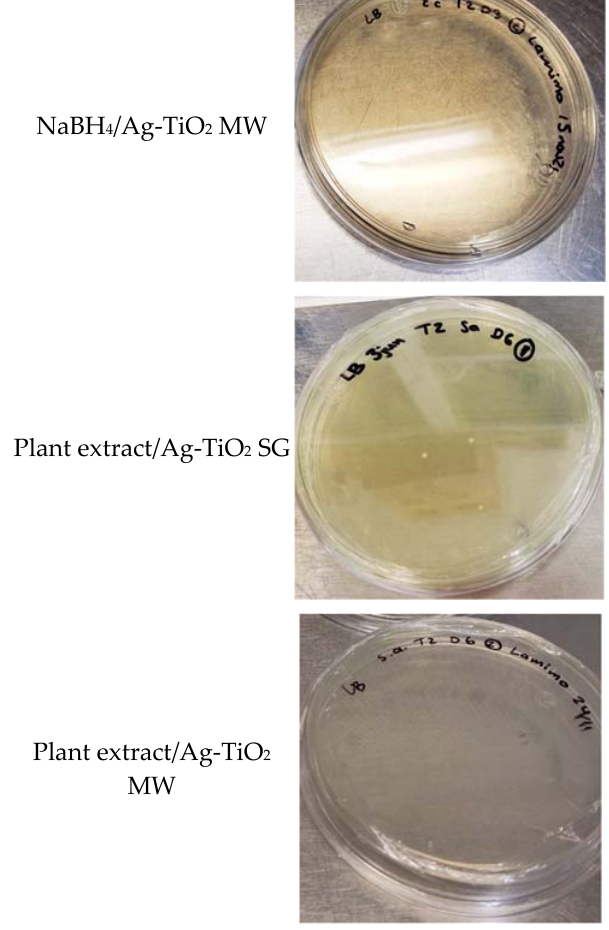
Figure 11. Images of bacterial inhibition growth of Ag NPs, TiO 2 , and Ag-TiO 2 materials.